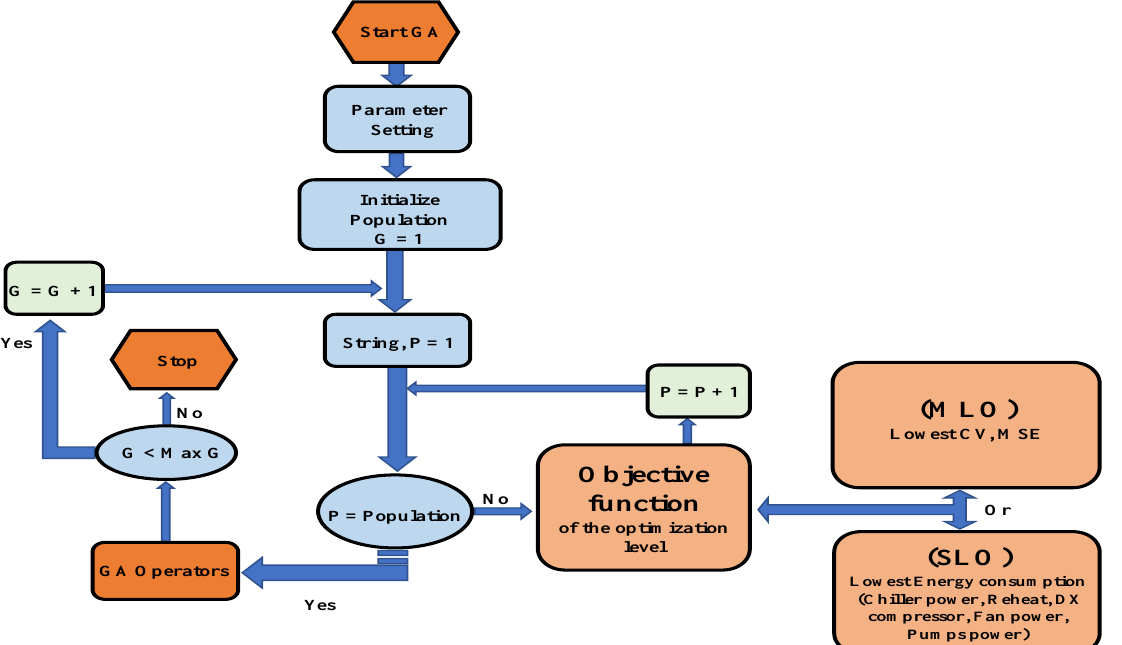
Figure 1. A schematic of the integrated optimization process.